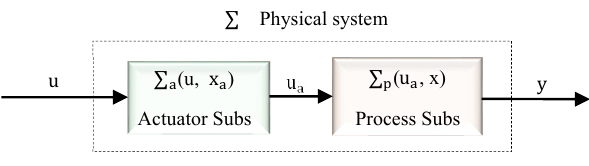
Figure 1. Structure of an interconnected system.